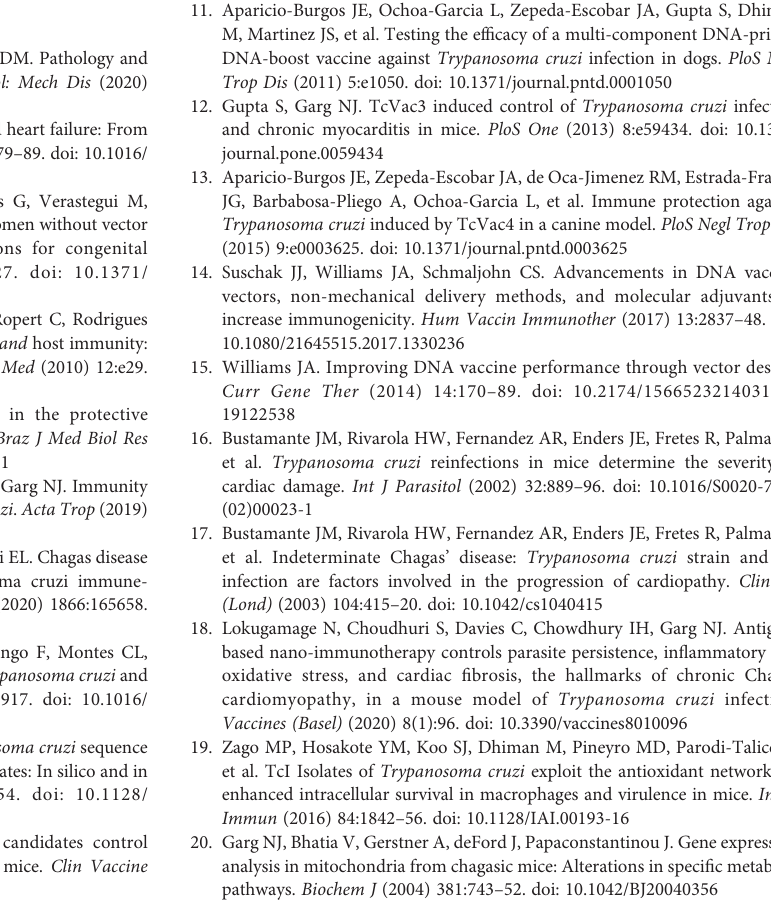
SUPPLEMENTARY FIGURE 1 | Schematics for the analysis of T-cell population pro fi le. Mice were immunized with p2/4 or nano2/4, infected with T. cruzi , and euthanized at day 10 and day 21 after challenge and at day 7 after re-infection, as described in Figures 1A and 2A . Splenic cells from all mice ( n ≥ 5 per group) were analyzed by fl ow cytometry. CD3 + splenic T cells (1 × 10 5 live cells per mouse) were cumulatively analyzed by FlowSOM software. (A) CD3 + T cells are presented in a total of 49 nodes in a 7 × 7 grid, based on the expression levels of CD4, CD8, CD25, CD62L, and CD44 antigens. (B) Phenotypically similar nodes from panel A were clustered into metaclusters, numbered P0 – P9. (C) Relative median fl uorescent intensitiesofsurfacereceptorsfromallthecohortsatallthetimepointswereutilizedto visualize as heatmap for 10 meta-clusters of CD3 + live T cells. Each row represents a sub-population based on expression of markers presented in the columns. The percentage of cells expressing surface markers is visualized with color scale from green (0) to red (1,000). (D) Mean value (± SEM) for the expression levels of the fi ve surface receptors in P0 – P9 sub-populations are shown. (E) Common t-Distributed Stochastic Neighbor Embedding (t-SNE) presentation of metaclusters. SUPPLEMENTARY FIGURE 2 | Comparison of dynamics of T cell sub- populations at early and late stages of acute T. cruzi infection in vaccinated and non-vaccinated mice. C57BL/6 mice were immunized, infected, and euthanized on day 10 and day 21 pi, as described in Figure 1A . Splenocytes were labeled